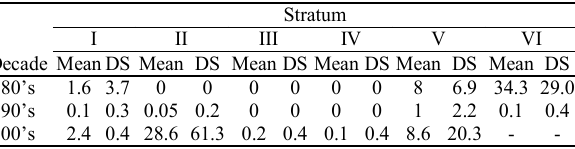
figure 10. At sizes larger than 75 mm TL